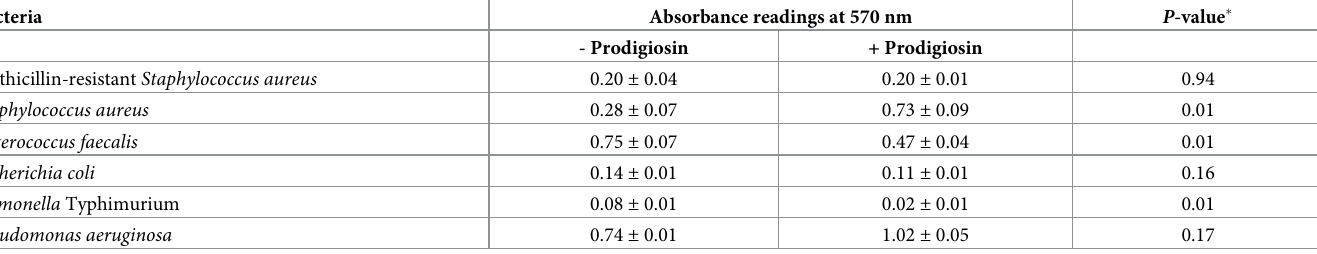
Table 4. Biofilm formation by prodigiosin-treated and untreated bacterial cultures after 48 hours incubation. Data are presented as averages and standard deviations (n = 3).